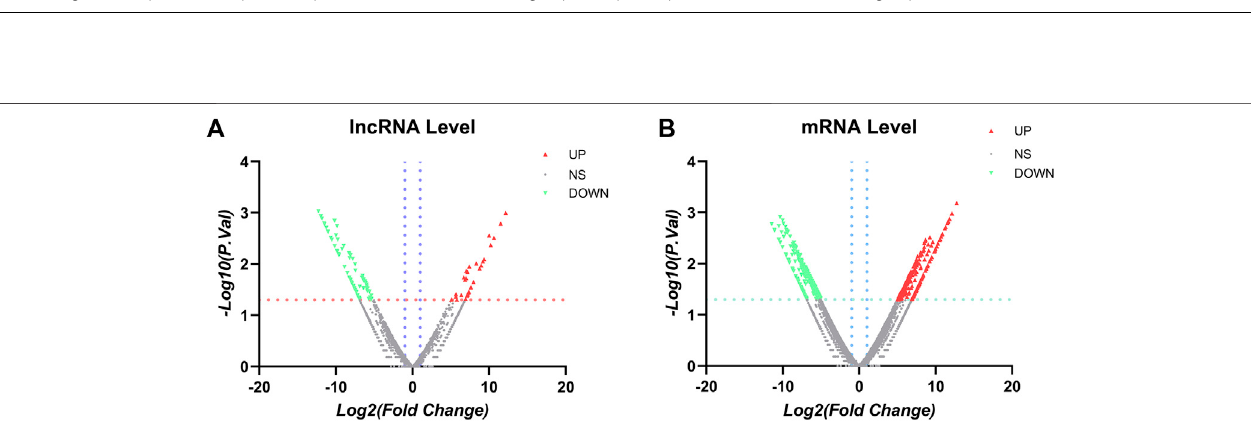
FIGURE3| HeatmapofDEGsinovariancancer: (A) Heatmapof117DElncRNAclusters. (B) Top50mostsigni fi cantDEGs.Note:tissuesamplesarepresentedas columns; individual genes are represented as rows. In patients with ovarian cancer, red indicates genes with upregulated expression, and green indicates genes with downregulated expression. Top, blue represents the ovarian cancer group, and pink represents the uterine fi broid group.